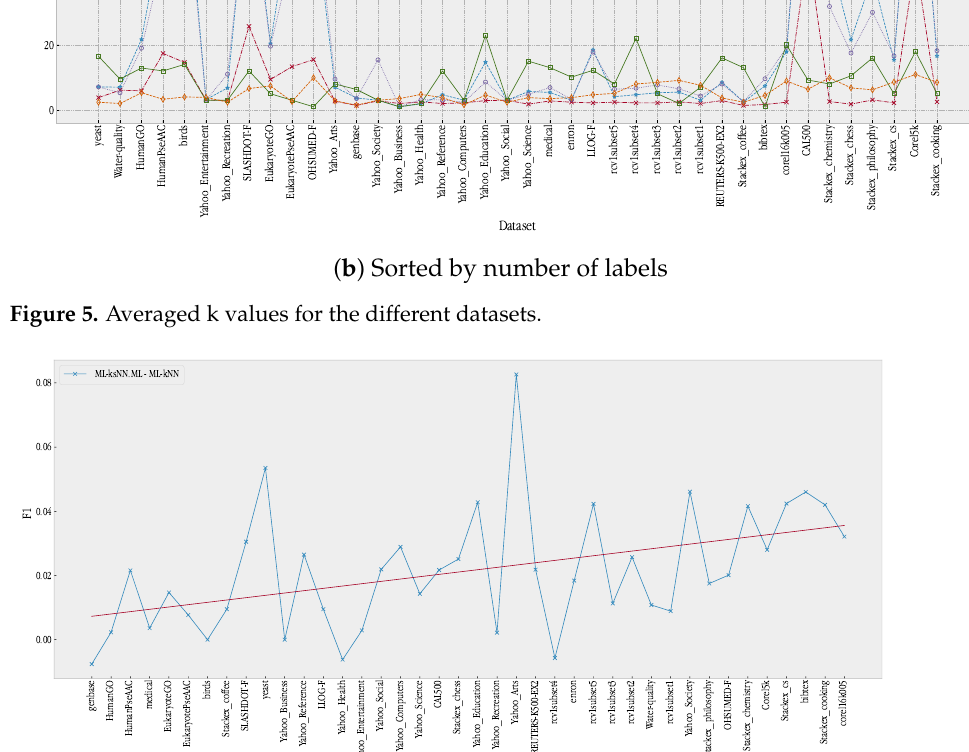
( a ) Sorted by number of features